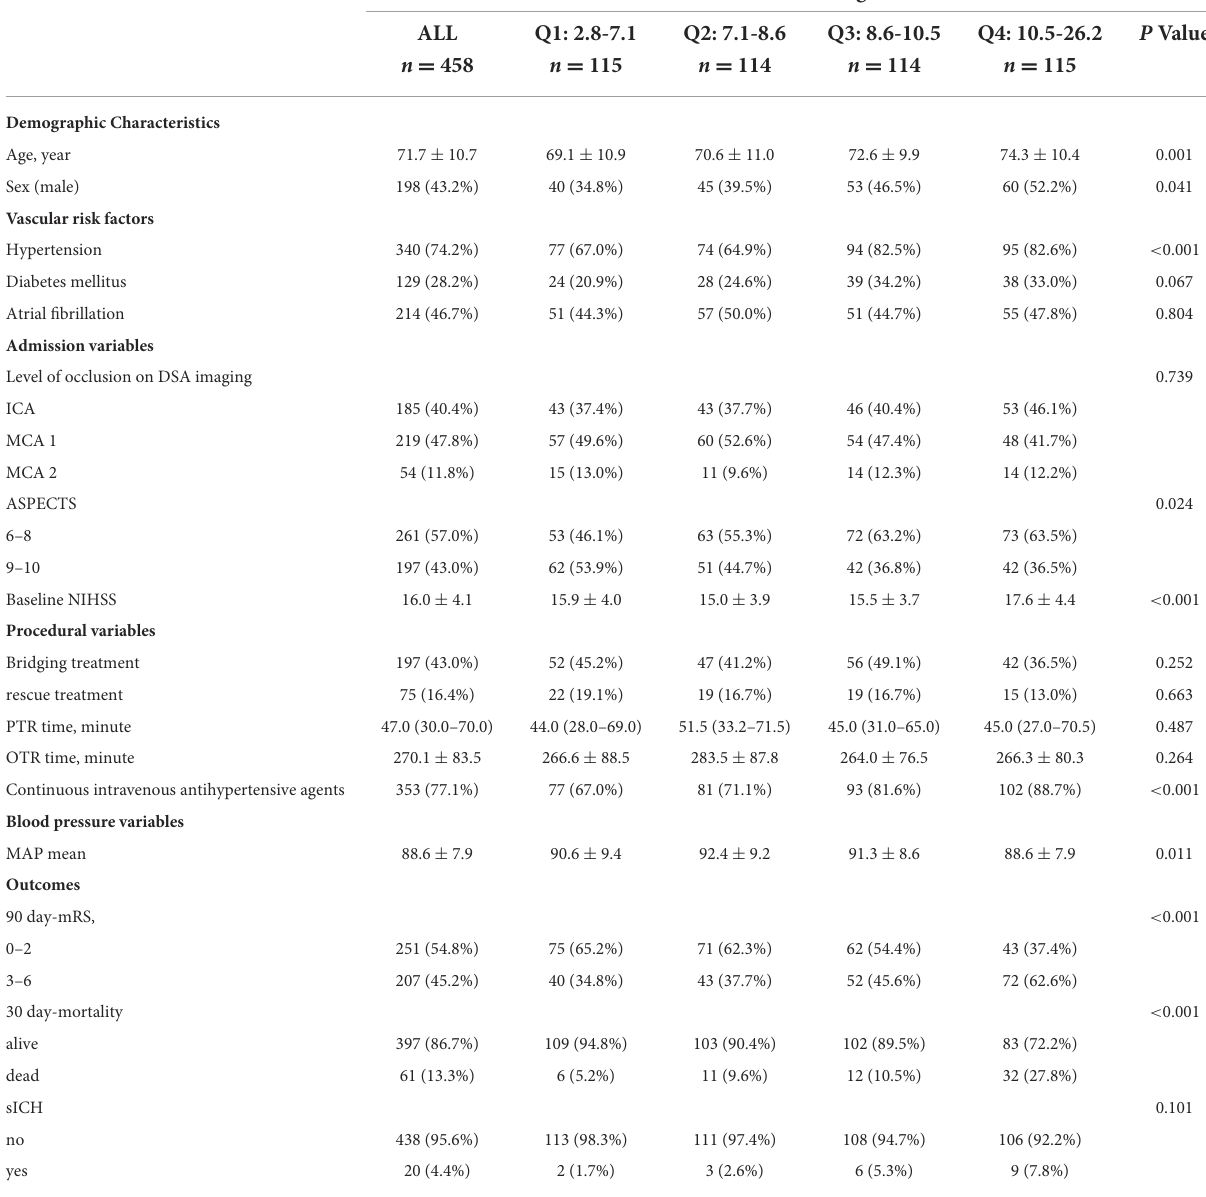
TABLE 1 Characteristics of the study population ( n =